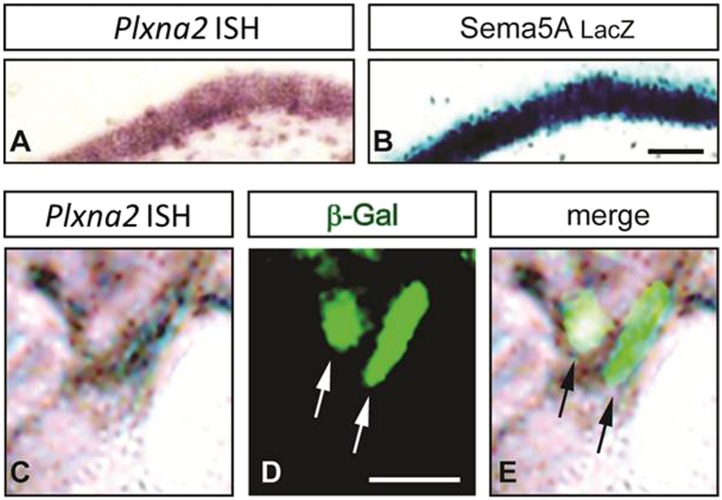
Sema5A and PlexA2 are co-expressed in GCs and interact in cis and in trans.(A and B) Coronal sections of adult Sema5AlacZ/lacZ mice were subjected to staining for Plxna2 mRNA (purple) or nuclear β-galactosidase (blue) by X-gal. (C–E) High magnification view of the dorsal DG. Overlapping labeling for Plxna2 mRNA and nuclear β-galactosidase was observed in GCs. Scale bars in A and B = 500 μm.